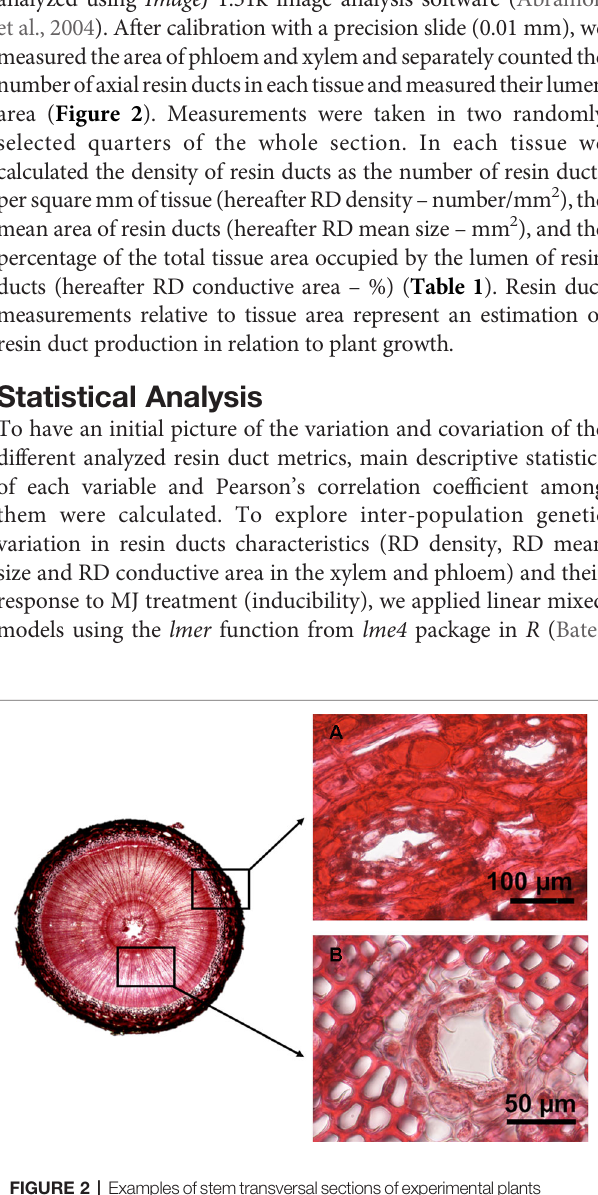
FIGURE 2 | Examplesofstemtransversalsectionsofexperimentalplants showingaxialresinductsinthephloem (A) andxylem (B) intwoyearold Pinuspinaster saplings.